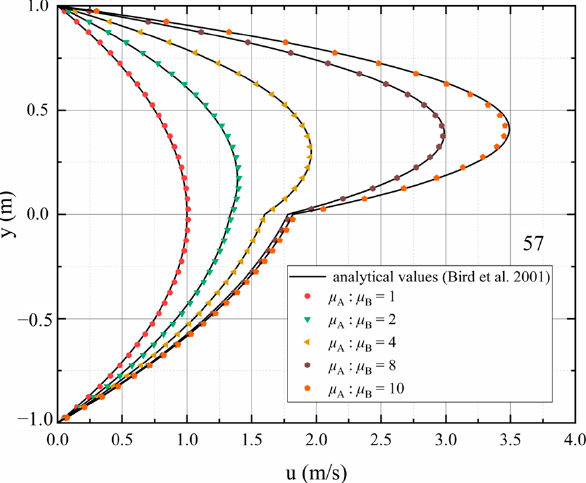
Figure 11. Velocity profiles of two-phase Newtonian Poiseuille flow tests.